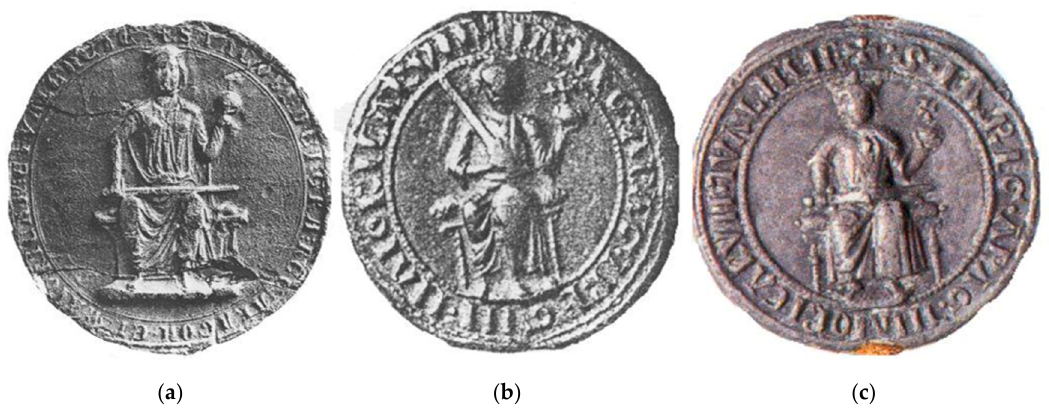
Figure 2. ( a ) Main seal of Jaime I, obverse. 1238–1276. From (De Sagarra i Siscar 1916–1932, n. 28). ( b ) Bull of James I, obverse. 1231–1238 (ibid., n. 25). ( c ) Bull of Jaime I. 1255. From (Conde 1992, p. 114). All the seals show the preeminence of the sword in the seals of James I. Used with permission according with publishing rules in Spain. Arts 2020 , 9 , x FOR PEER REVIEW